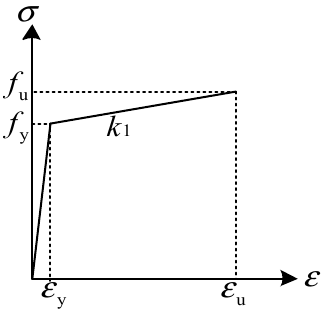
Figure 1. The stress-strain skeleton curve of steel.